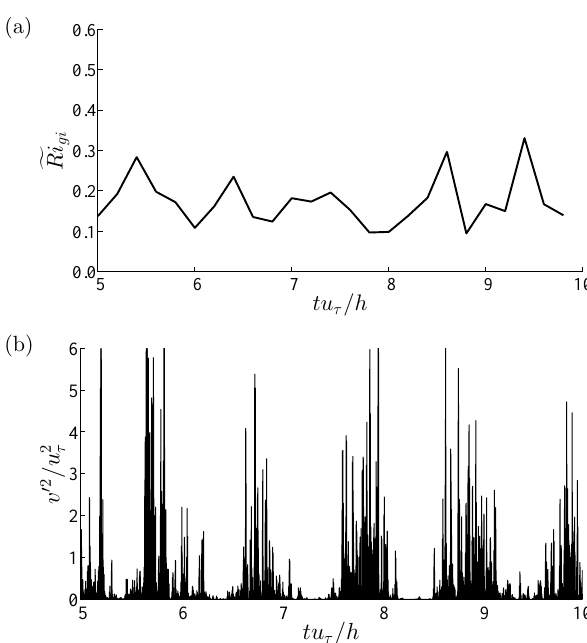
Figure 21. Time series of streamwise velocity in the channel. (a) Re τ = 395, Ri τ = 960, and (b) Re τ = 550, Ri τ = 2880.